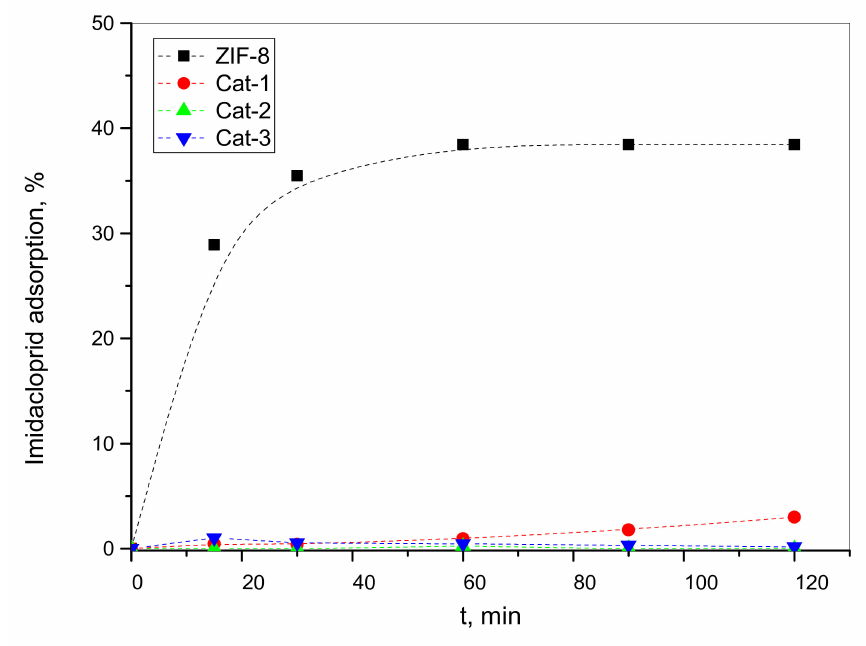
Figure 6. Adsorption of imidacloprid on mechanochemically synthesized ZIF-8 and on hybrid TiO 2 /ZIF-8